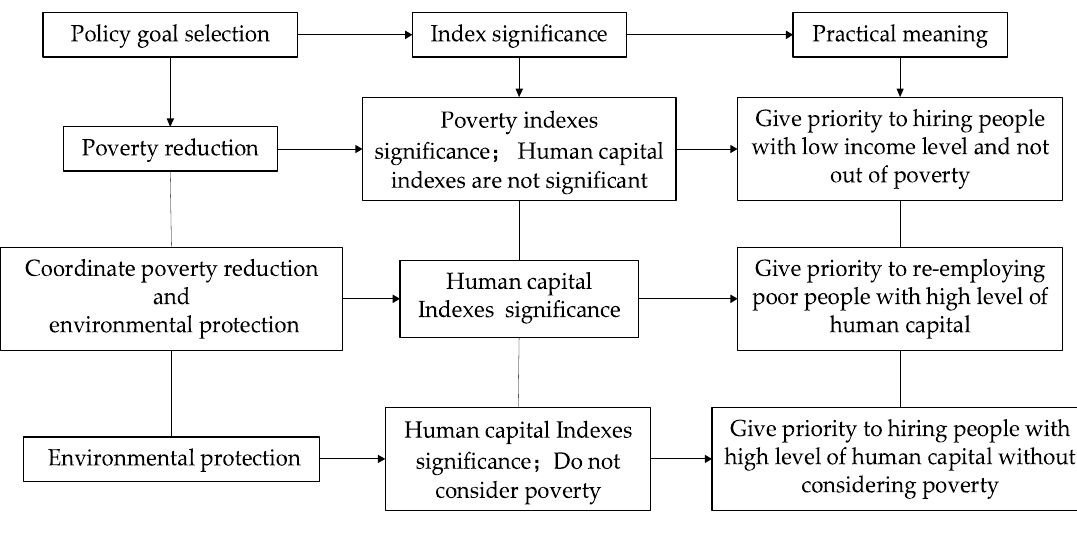
Figure 2. Verification idea.